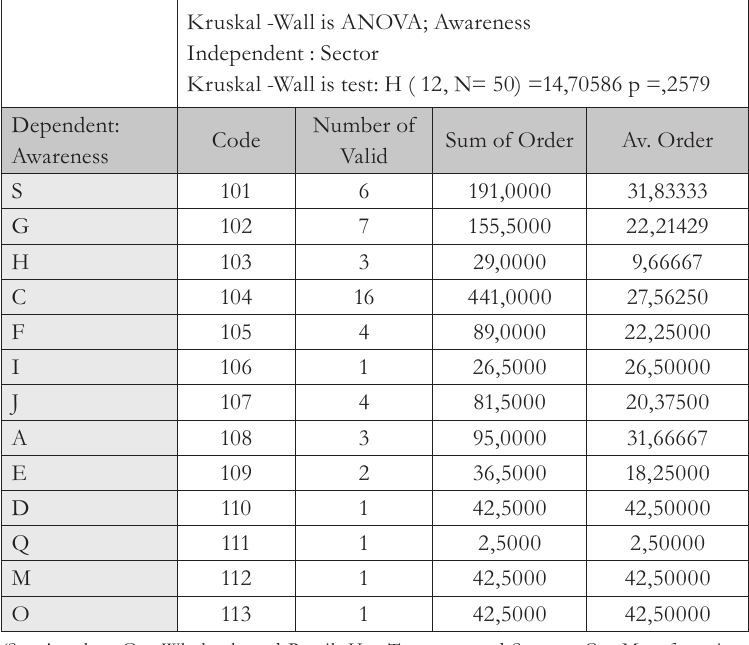
Tab. 5 – Kruskal-Wallis test, Awareness and Sector, Source: Own processing at STATISTICA, 2015 Kruskal -Wall is ANOVA;